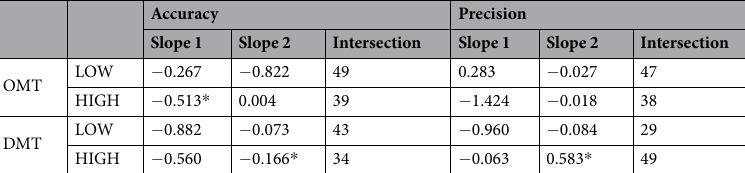
Table 1. Slopes and intersection of the of the trend lines obtained by stepwise linear regression analysis for controlled force.